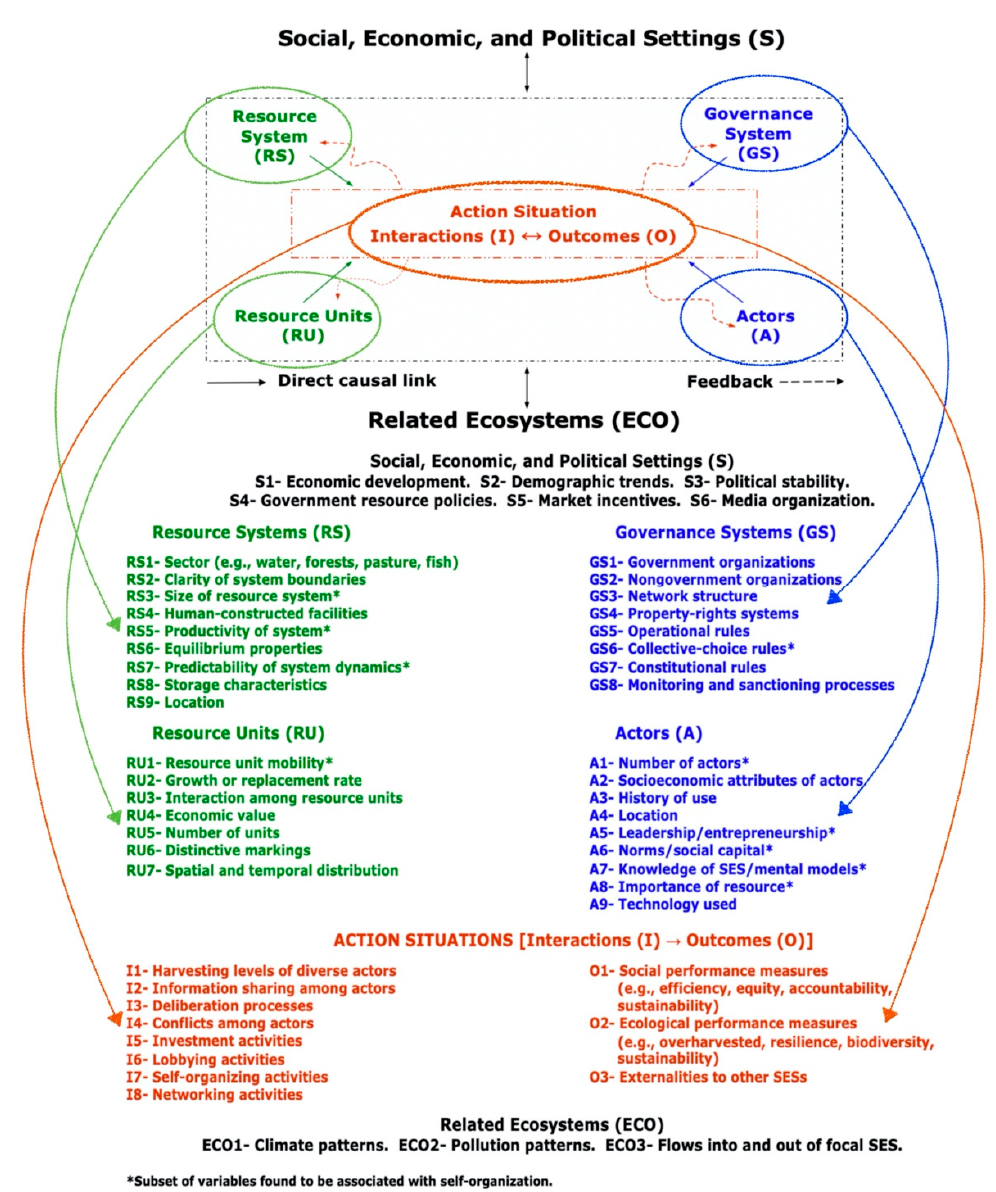
Figure 1. SES and second-tier variables, adapted from Ostrom (2007, 2009) [20,21].